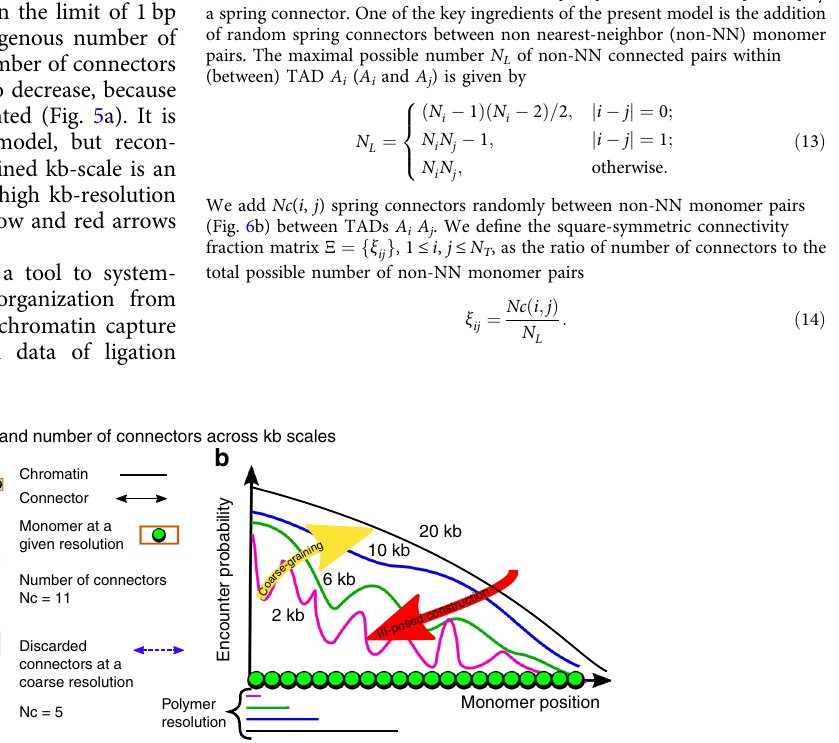
Fig. 5 Illustration of polymer reconstruction of chromatin at different kb-scales. a Two examples of polymer reconstruction at 2 (Upper) and 10 kb (bottom) resolution, where the number of connectors Nc vary with the scale Nc = 11 (2 kb) and Nc = 5 (10 kb). For coarse scale, connectors within the same bin (orange boxes) are discarded. b Effect of coarse-graining on the encounter probability. It is possible to coarse-grain (yellow arrow), while the construction of a re fi ned polymer model from a coarse-grained resolution (red arrow) is an ill-posed problem NATURE COMMUNICATIONS| (2019) 10:2626